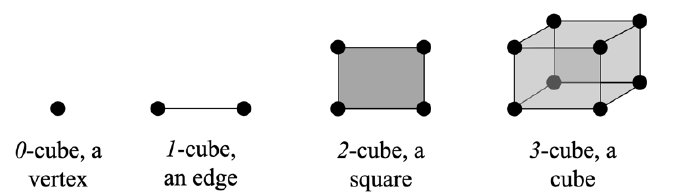
Figure 3. Visual summary of the general process for topology-regulated background extraction of eye fundus digital images.